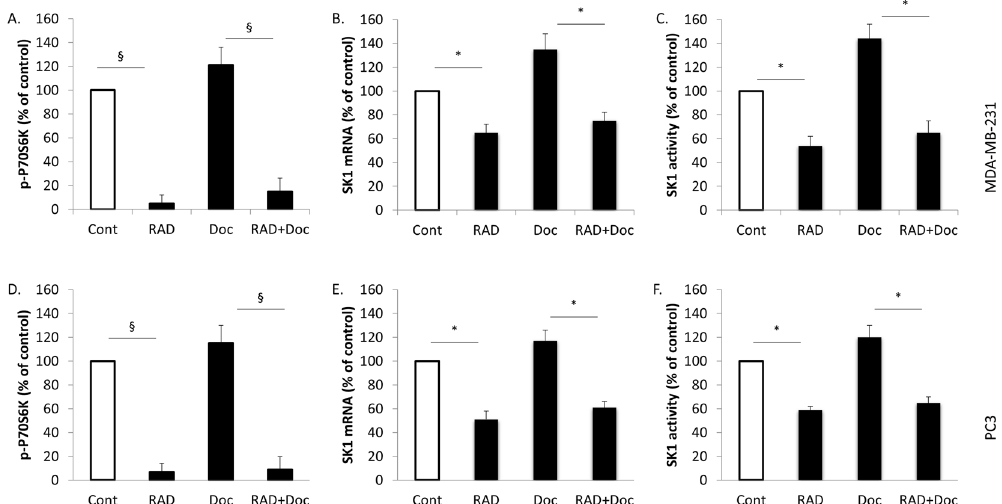
Figure 2. RAD001 but not docetaxel decreases SK1 expression in MDA-MB-231 and PC3 cells. MDA-MB-231 and PC3 cells were starved overnight then incubated with 0.1% DMSO (Cont), 100 nM RAD001 (RAD), 5 nM docetaxel (Doc) and the combination of these drugs (RAD + Doc) for 24 h. ( A , D ) P70S6K phosphorylation was measured using ELISA. ( B , E ) SK1 expression was determined by qRT-PCR. ( C , F ) SK1 activity was measured using radiolabelling. Columns, mean of three independent experiments performed in triplicate; bars, SEM. ( * P < 0.05; ** P < 0.01; § P < 0.001; ns, not significant, P >